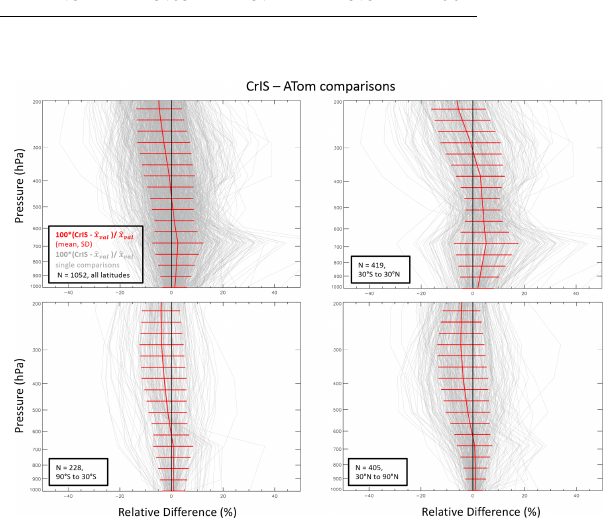
Figure 7. Relative differences (%) in single CrIS retrievals with coincident ATom ˆ x val profiles (grey) and the average percent dif- ference with 1 σ horizontal bars (red). Latitude ranges are indicated in each panel along with the number of comparison pairs. Both day and night CrIS observations are